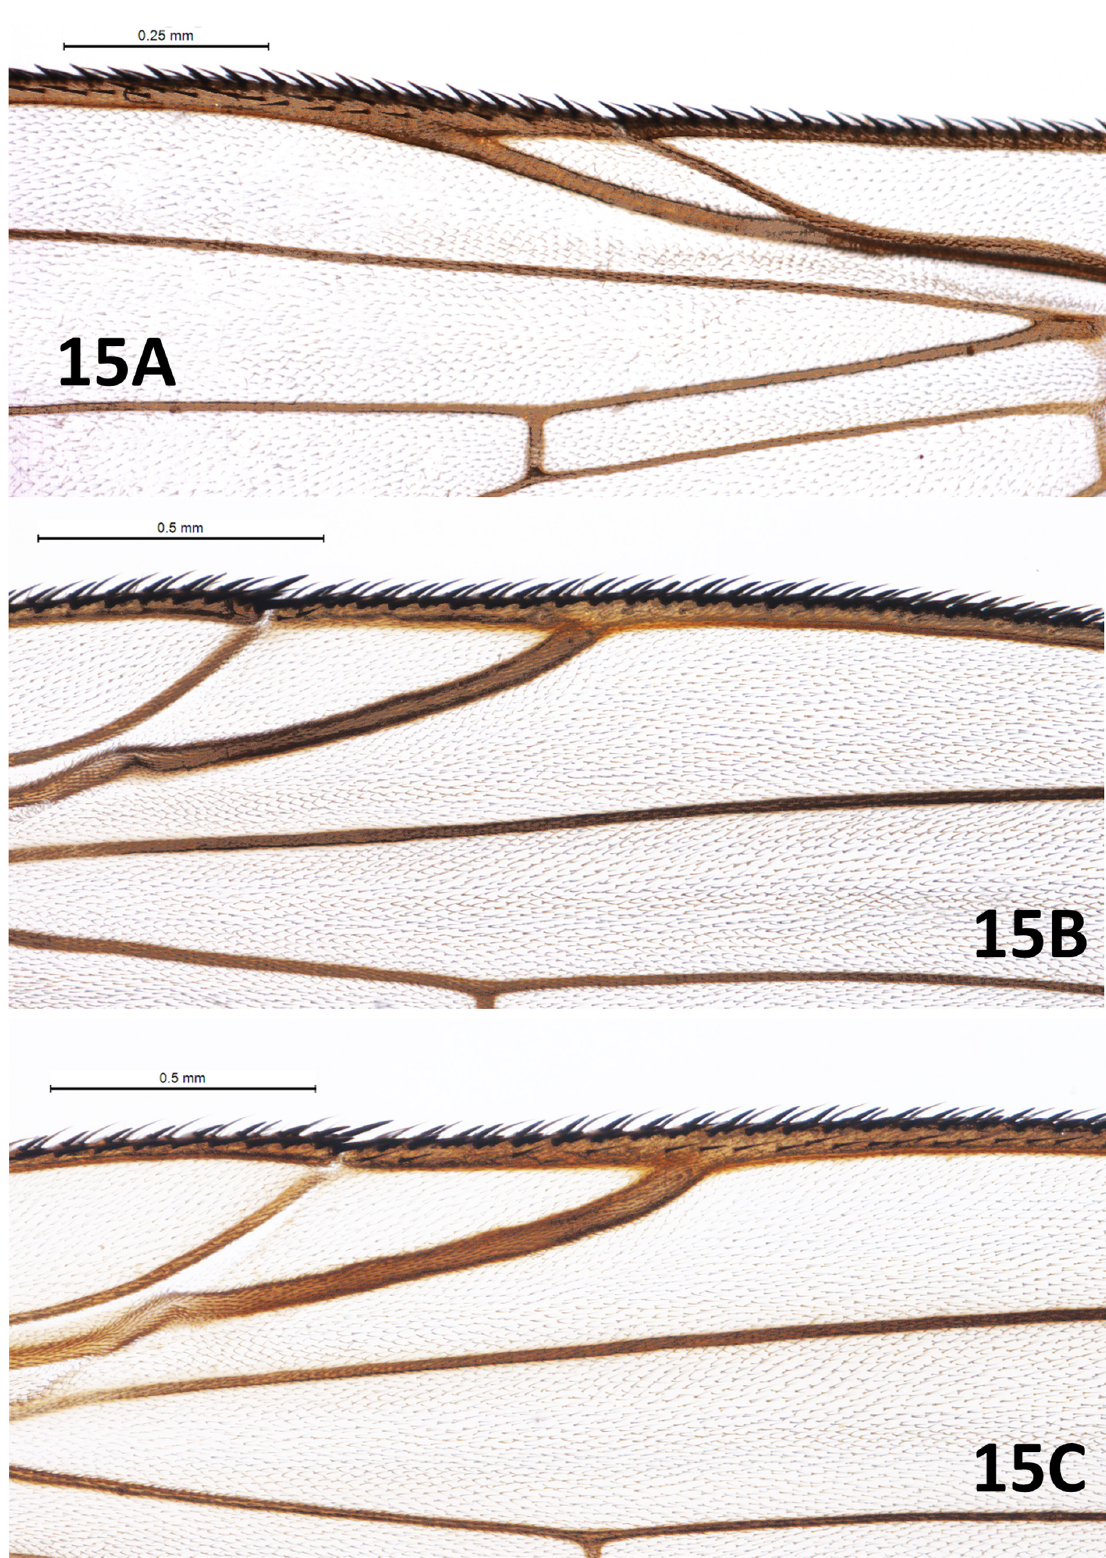
Fig. 15. ♀♀ of Muscidae Latreille, 1802. A . Myospila bimaculata (Macquart, 1834), detail of wing showing CS1–3, dorsal view. B . Mydaea ancilla (Meigen, 1826), detail of wing showing CS1–3, dorsal view. C . M . affinis Meade, 1891, detail of wing showing CS1–3, dorsal